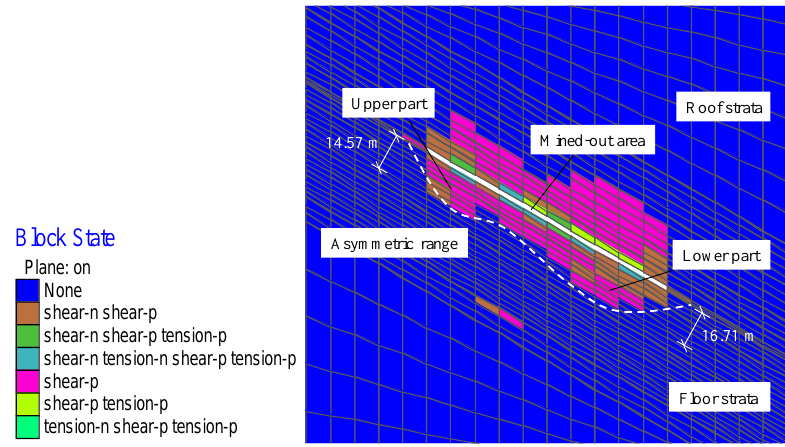
Figure 12. Distribution of the numerically obtained failure zone in the inclined floor strata.